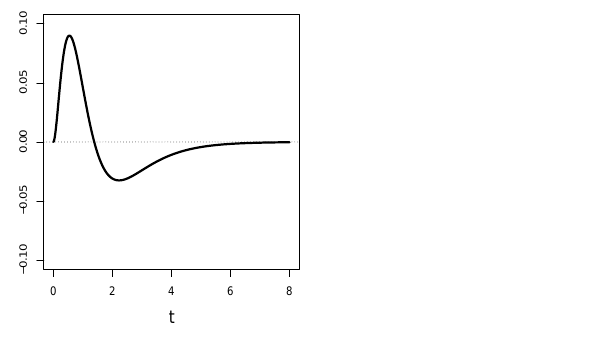
Figure 7. DIC ( t ) of a 1-direction serial exhaustive system that obeys the Dzhafarov’s